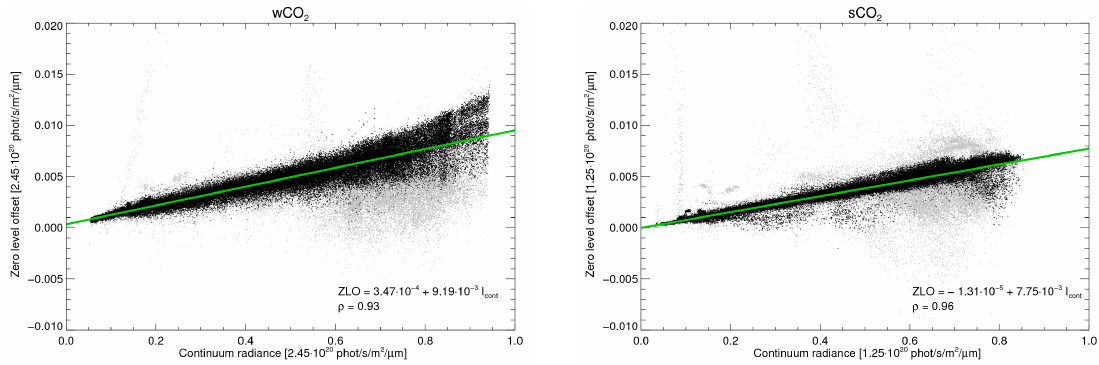
Figure 6. Retrieved zero level offset (ZLO) versus continuum radiance (I cont ) for all four fit windows. gray dots : potential outliers, (i.e., no convergence, χ 2 > 2, or RSR exceeding threshold (see Figure 4)). green line : linear